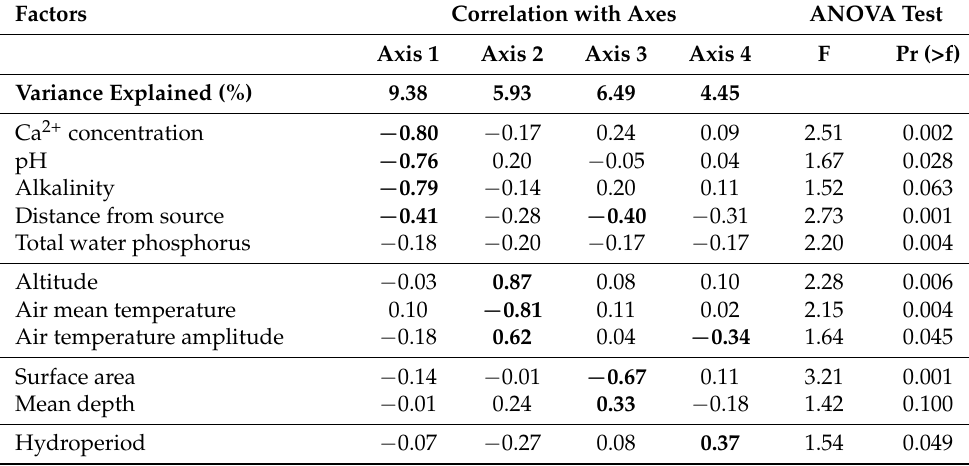
Table 2. Results of correlations between axes and environmental variables and ANOVA-like per- mutation test performed on db-RDA computed with macrophyte abundance, based on taxonomic composition against forward selected environmental variables. Pr(>f) = p values of the permutation tests. Best correlation values for each axis are